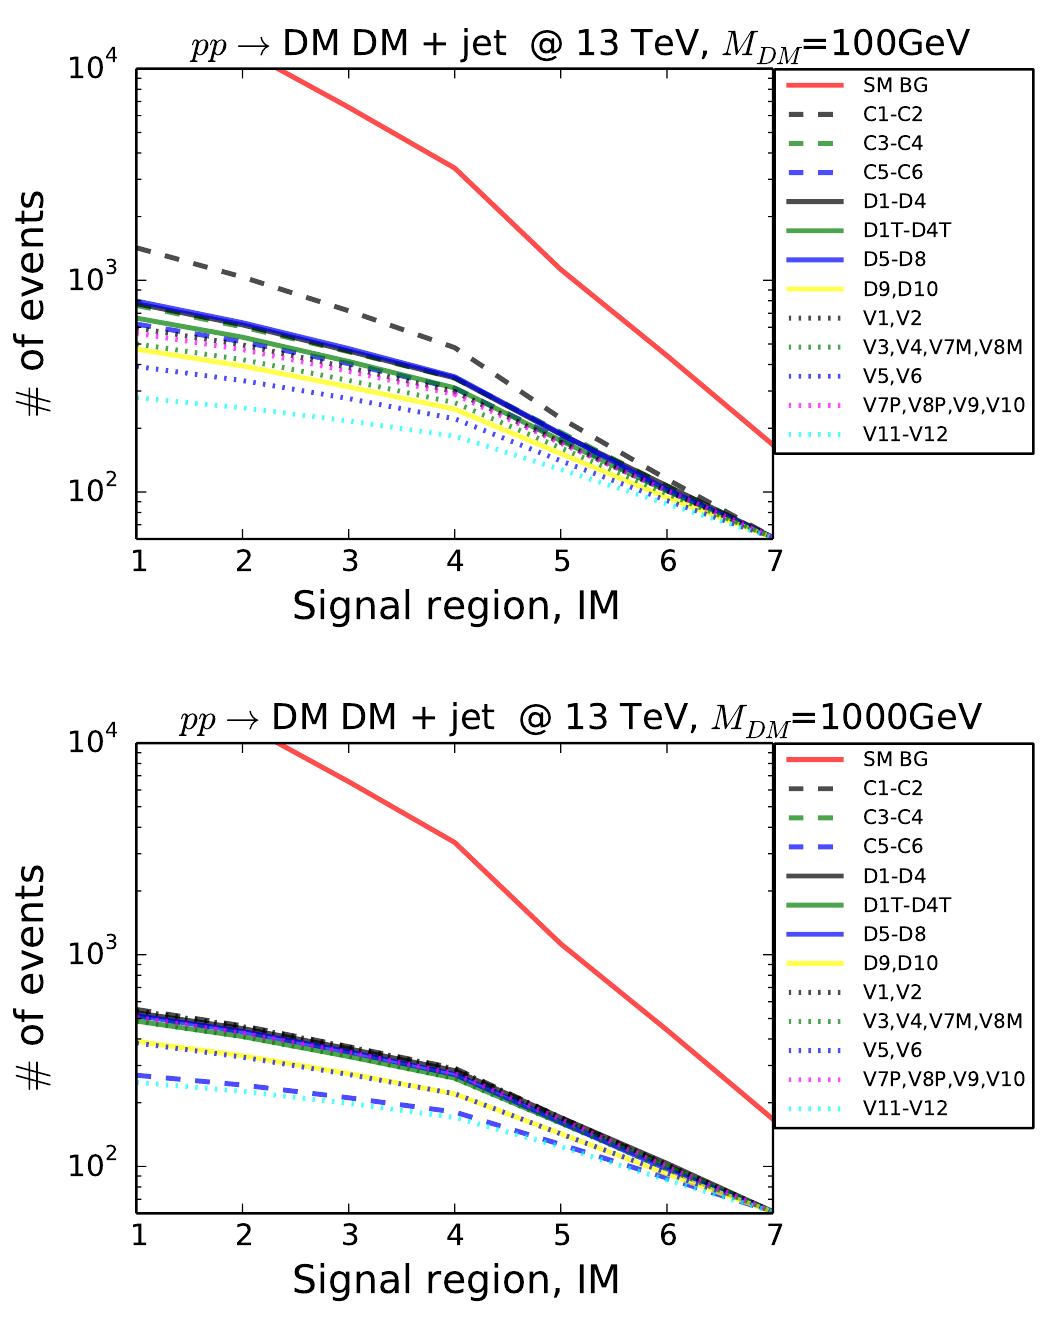
Figure 12 . The number of signal events for the EFT operators under study for IM i bins ( i = 1 (cid:0) 7) with the signal normalised to 61 events (maximal allowed deviation from SM BG at 95% CL) in the IM 7 bin. The SM BG is normalised to the same amount of events is also presented for the sake of the comparison of its shape to the signal. The top and bottom panels of the (cid:12)gure present results for M DM = 100 and 1000 GeV